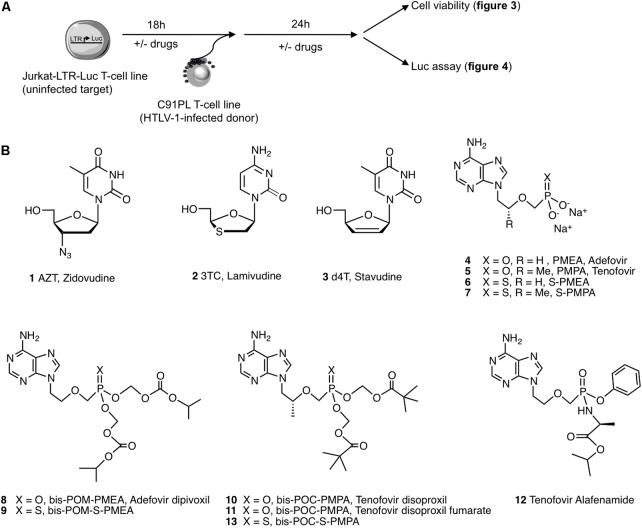
Experimental assay and chemical structures of compounds used in this study. (A) Schematic representation of the experimental procedure. Jurkat-LTR-Luc [reporter cells for HTLV-1 productive infection in which expression of the luciferase gene is under the control of the viral Tax-dependent promoter (LTR)] are pretreated or not with drugs for 18 h before their co-culture with C91PL (HTLV-1 infected T-cell line) for 24 h. Cell viability and luciferase activity are then measured. (B) AZT (1) is used as the reference drug during all experiments, while 3TC (2) and d4T (3) are used as controls; the acyclic nucleoside phosphonate PMEA (4), its thio-derivative S-PMEA (6) and their prodrugs (8) and (9), respectively; the acyclic nucleoside phosphonate PMPA (5), its thio derivative S-PMPA (7) and their pro-drugs (10), (11), (12), and (13), respectively. Structures were drawn using ChemDraw. The molecule names (when available) are indicated under the structure.